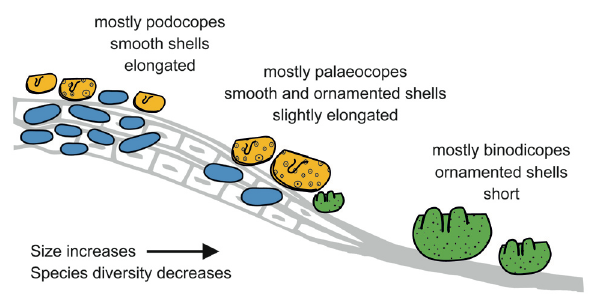
Fig. 13. General changes in ostracod assemblages along the facies gradient (see Fig. 2). Ostracods generally had smooth shells in the mixed facies (this can be seen in all major taxonomic groups – podocopes, palaeocopes and binodicopes), smooth and tuberculate shells in the mud-supported facies and (according to the preliminary data) punctate shells in the black shale